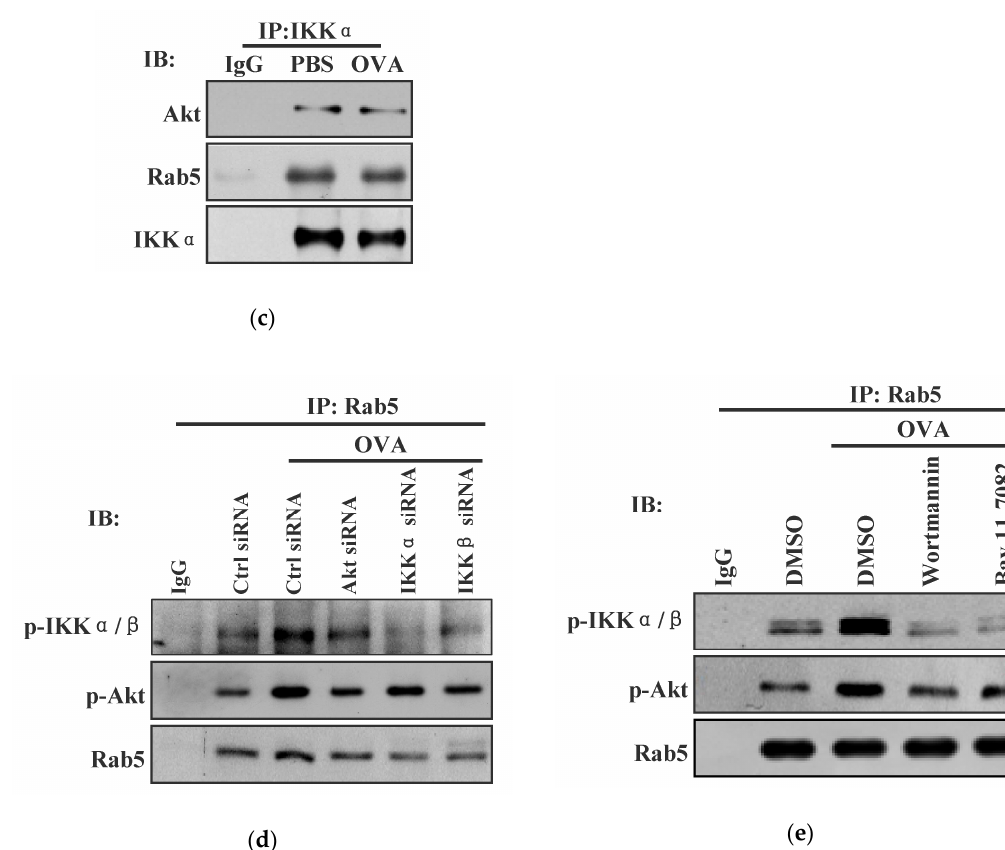
Figure 4. Endotoxin-containing pathogen promotes the formation of Akt + IKK α / β + Rab5 + signalosome in bone marrow precursor cells. ( a – c ) Murine BMPC was incubated with endotoxin-containing pathogen ovalbumin (50 µ g / mL) and the interaction of Akt-IKK α / β -Rab5 was assessed by Co-IP with Rab5 (A), Akt (B), or IKK α ( c ) antibody. Isotype IgG was used as negative control. Murine scramble, Akt / IKK α / IKK β deficient ( d ), or Bay11-7082 / wortmannin (5 µ mol / L) pretreated ( e ) BMPC was incubated with endotoxin-containing pathogen ovalbumin (50 µ g / mL). The interaction of phosphorylated IKK α / β with Rab5, phosphorylated Akt with Rab5 were investigated by Co-IP with Rab5 antibody. Isotype IgG was used as negative control. Control siRNA or DMSO with ovalbumin was used as endotoxin-containing pathogen control. Control siRNA or DMSO without ovalbumin was used as scramble control. One representative from three independent experiments is shown. OVA: endotoxin-containing pathogen ovalbumin.